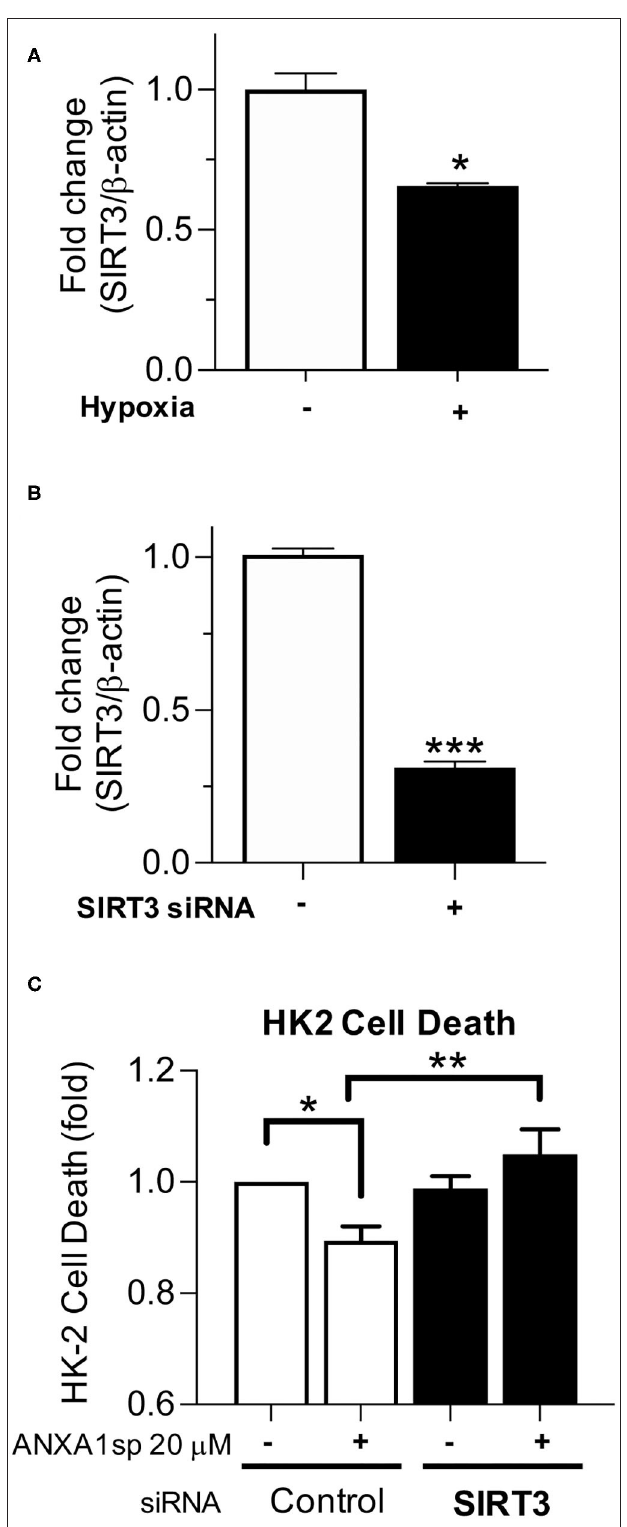
FIGURE 6 | Silencing of SIRT3 prevents ANXA1sp-mediated protection from kidney cell death. (A) HK-2 cells were exposed to normoxic conditions or